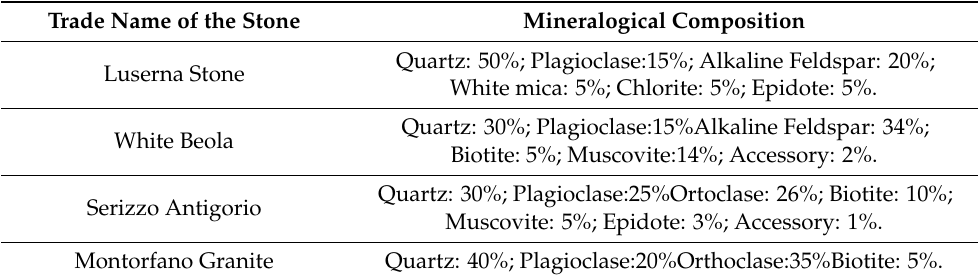
Table 1. List of the stones studied with their trade names and mineralogical composition. Trade Name of the Stone Mineralogical